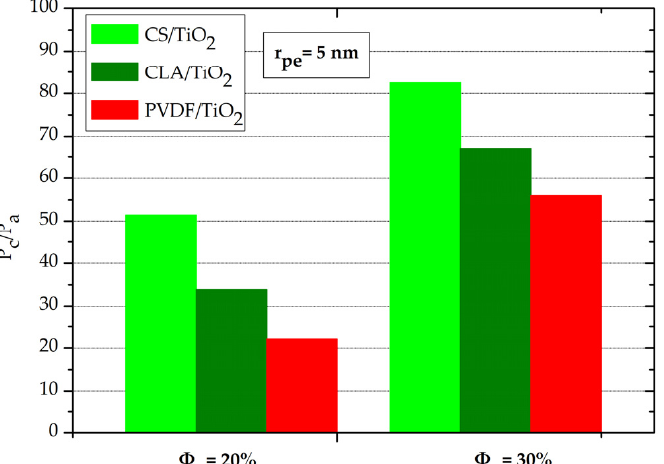
Figure 5. Normalized capillary pressure P c /P a at r pe = 5 nm and Φ = (20% and 30%) for CS/TiO 2 , CLA/TiO 2 and PVDF/TiO 2 nanocomposites.